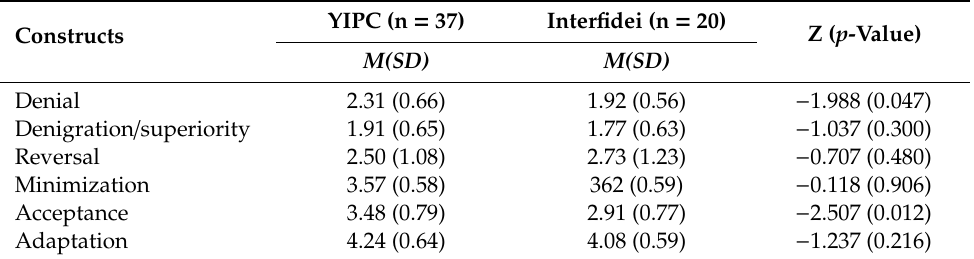
Table 8. Organization-related di ff erences of IRSSQ